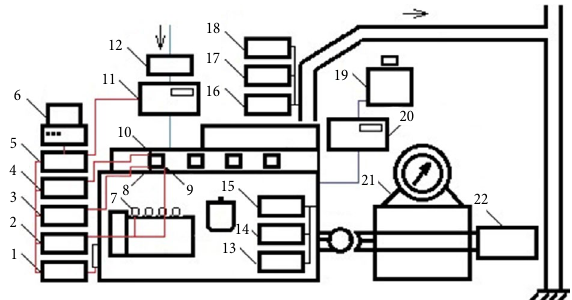
Fig. 1. Engine test bed scheme: 1 – crank angle encoder; 2 – am- plifier Kistler 4665 ; 3 – amplifier Kistler 5247 ; 4 – amplifier Mi- croifem ; 5 – indicating system AVL IndiModul 622 ; 6 – personal computer; 7, 9 – pressure sensors; 8 – needle valve lifting sen- sor; 10 – cylinder gas pressure sensor; 11 – air mass flow meter; 12 – air filter; 13, 14 – engine coolant and oil temperature sen- sors; 15 – engine oil pressure sensor; 16 – thermocouple; 17 – exhaust gas analyser; 18 – exhaust smoke meter; 19 – fuel tank;